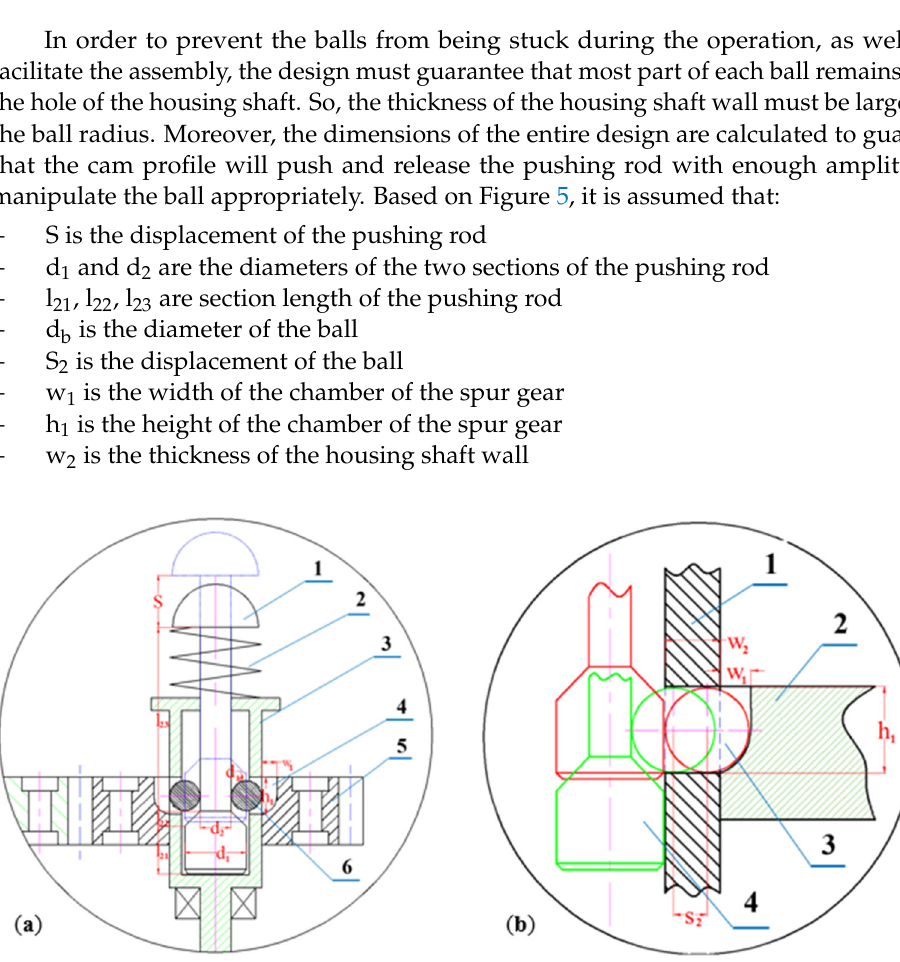
Figure 5. ( a ) Schematic view of the ball shifting mechanism; 1—Pushing rod; 2—Spring; 3—Housing shaft; 4—Ball socket; 5—Planet gear; 6—Ball. ( b ) Schematic view of the ball motion; 1—Housing shaft; 2—Planet gear; 3—Ball; 4—Pushing rod.